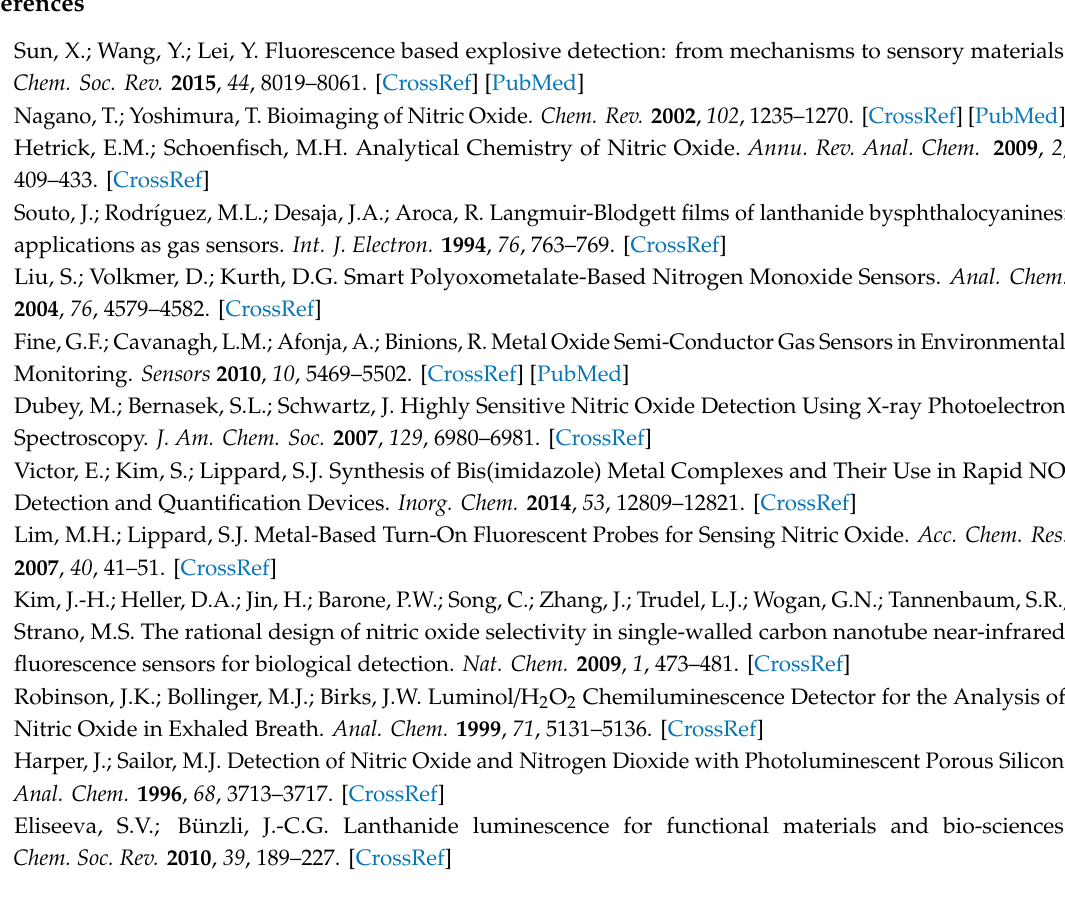
Figure S1: IR spectra of DOTAGA (L) and TbDOTAGA (TbL), Figure S2: High Resolution ESI MS spectrum of TbL (negative mode, MeOH), Figure S3: Determination of q, the number of water molecules coordinated to the Tb(III) center, Figure S4: Emission spectra of TbL (TbDOTAGA) in aqueous solution, solid state, and grafted at the Si surface (TbL@Si), Figure S5: TbL@Si 545 nm emission band evolution on the course of vacuum / NO cycles, Figure S6: Evolution of the relative emission band intensities according to the NO concentration, the reference being the 545 nm emission ( λ exc = 230 nm, black—490nm, light grey—545 nm, grey—585 nm, dark